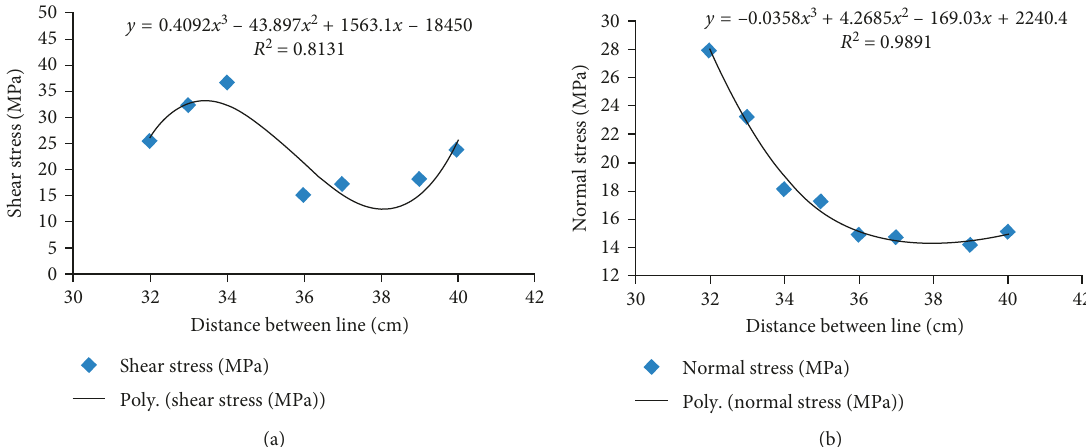
Figure 14: (a) Maximum shear stress and (b) maximum normal stress as a function of the distance between the rows of holes drilled in the square